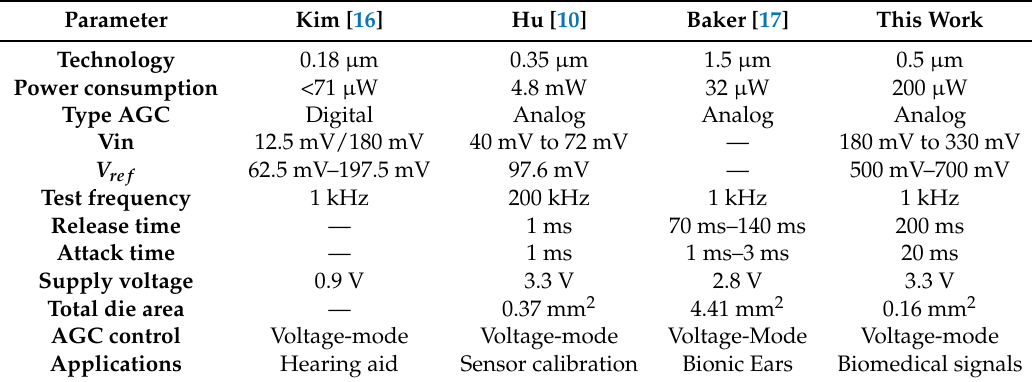
Table 3. Comparison with others